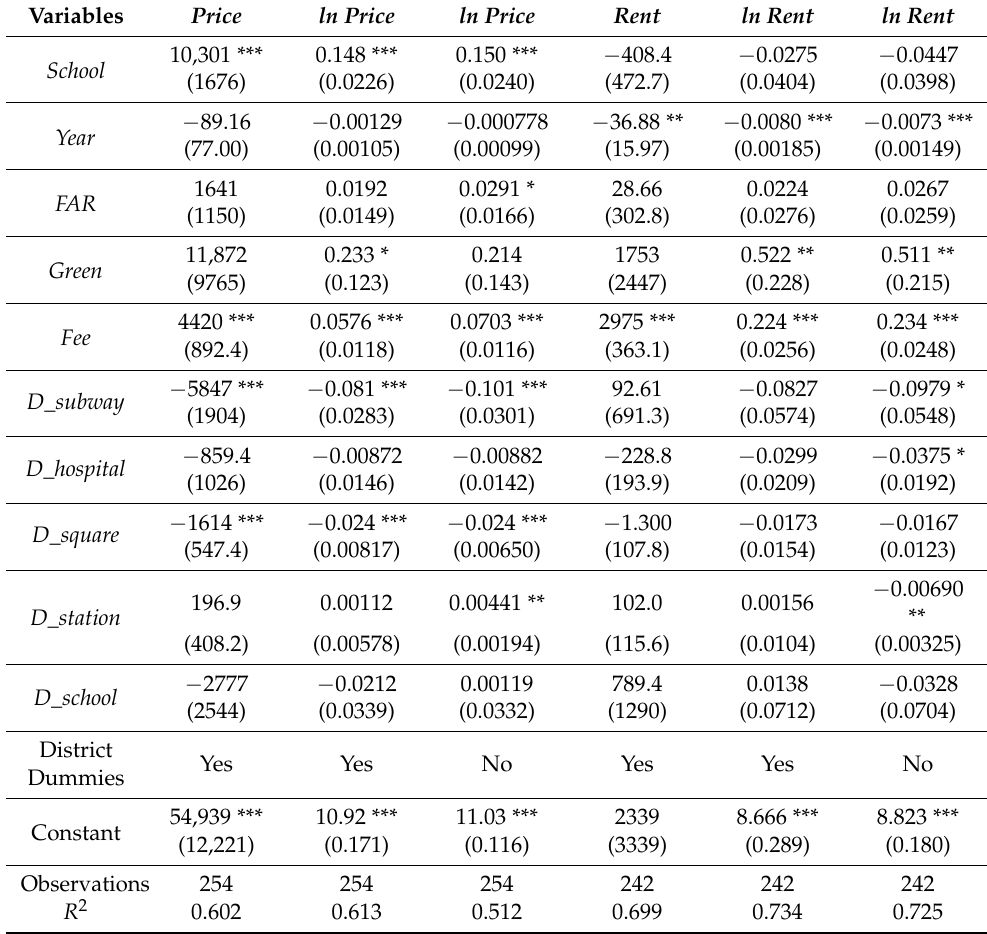
Table 3. Results of hedonic